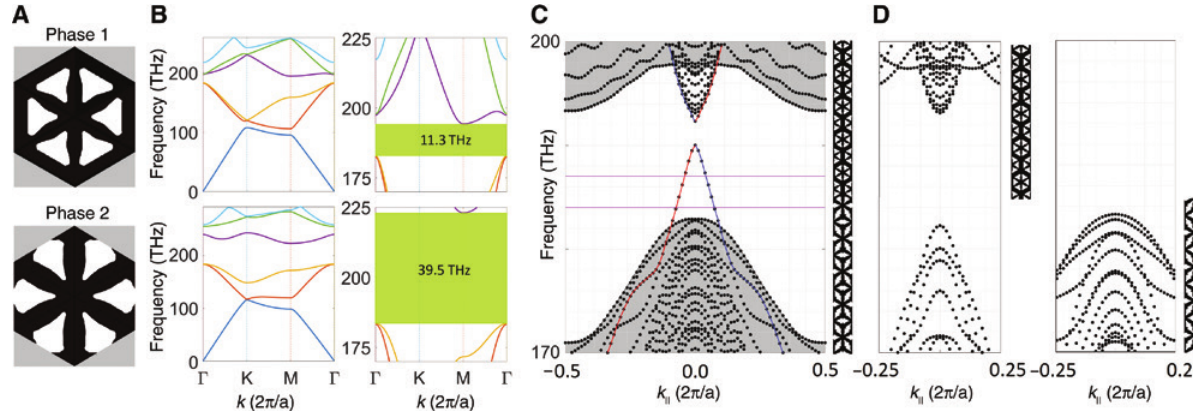
Figure 5: Geometries and band structures of PTIs. (A) The two photonic crystal (PC) phases constituting the photonic topological insulator (PTI). (B) Band structure diagrams for each individual PC phase showing the first six bands. (C) Band structures for the PTI supercell on the right, with the pseudo-spin edge modes highlighted in red and blue and the frequencies targeted in the TO process overlaid as horizontal magenta lines. (D) Band structures for the supercells, on the right, constructed from each PC crystal phase showing the appearance of the artificial standing wave Bloch modes in each phase seen in the PTI supercell band structure in